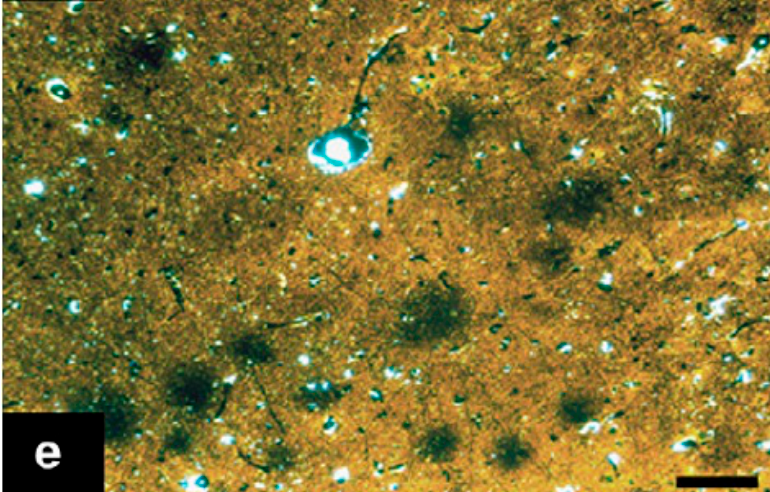
Figure 8. Diffuse plaques in the neocortex of a horse. Methenamine silver. Bar = 50 µ m. Reprinted from Journal of Comparative Pathology , 142, Capucchio M.T., Marquez M., Pregel P., Foradada P., Bravo M., Mattutino G., Torre C., Schiffer D., Catalano D., Valenza F., Guarda F., Pumarola M. Parenchymal and Vascular Lesions in Ageing Equine Brains Histological and Immunohistochemical Studies, 61 – 73, 2010, with permission from Elsevier